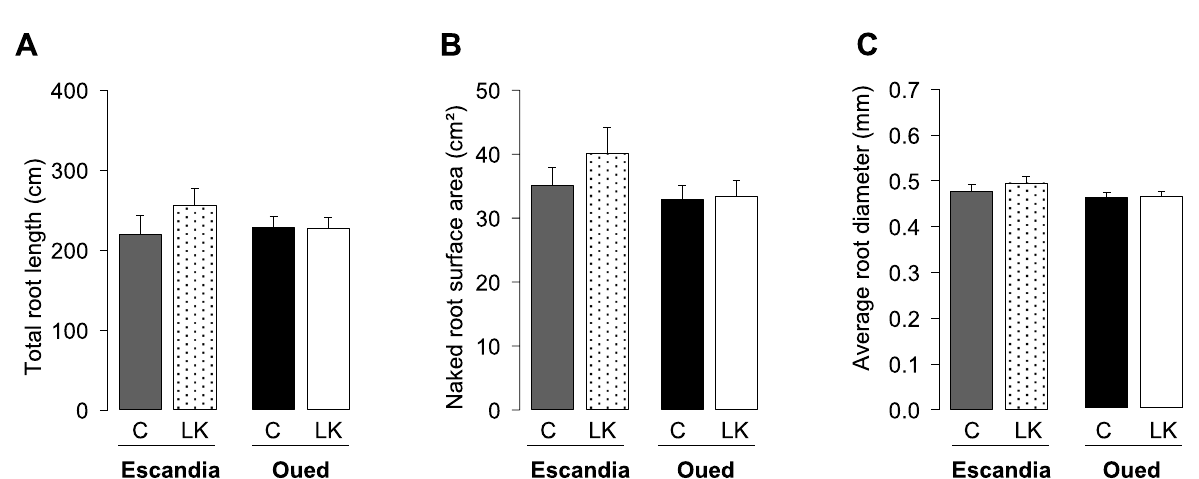
Fig. 5 Effect of K + shortage on total length of root system, on "naked" root surface area and on average root diameter in Escandia and Oued Zenati wheat seedlings. Plants were grown for 14 days in rhizoboxes in control or K + shortage conditions (see the legend to Fig. 2). A Total root system (seminal lateral root) length, obtained using WinRHIZO ™ software. Root elements displaying a diameter equal to or larger than 0.2 mm were + classified as roots, in contrast with root hairs that were assimilated to root elements with a diameter smaller than 0.2 mm. B “Naked” (when root hairs were not considered) root surface area, obtained using WinRHIZO ™ software. C Averaged root diameter over the entire root system (expressed in mm), calculated by dividing the “naked” root surface area (data in Fig. 5B) by the total root length (data in Fig. 5A) and by π (3.14). Means for control condition, and 14 for low K + condition, in Escandia; n 14 for both conditions in Oued Zenati). Absence of star above the bars indicates = no statistically significant difference between the values in control condition and the corresponding values in K. + shortage condition (Student t test; p >